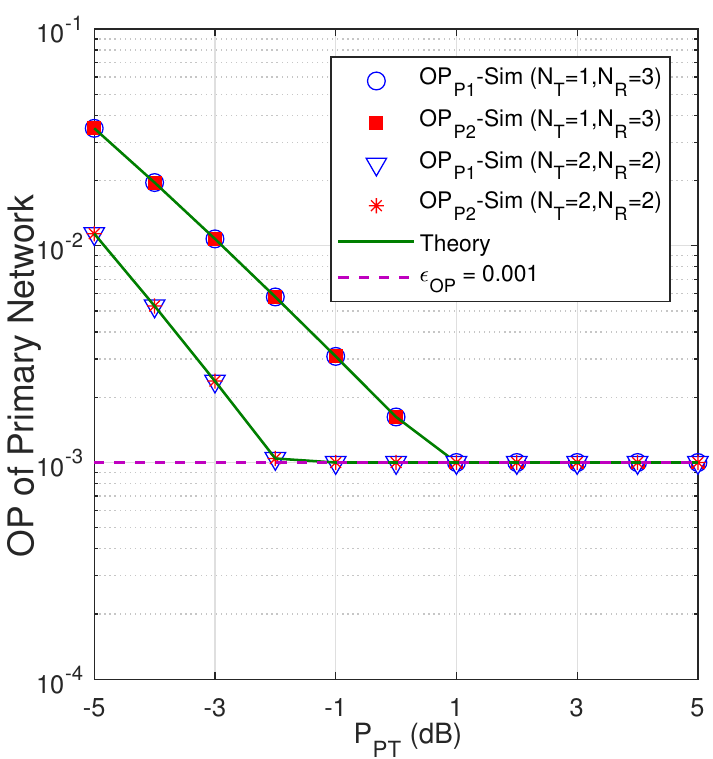
Figure 2. OP of the primary network as a function of P PT (dB) when x R = 0.3.